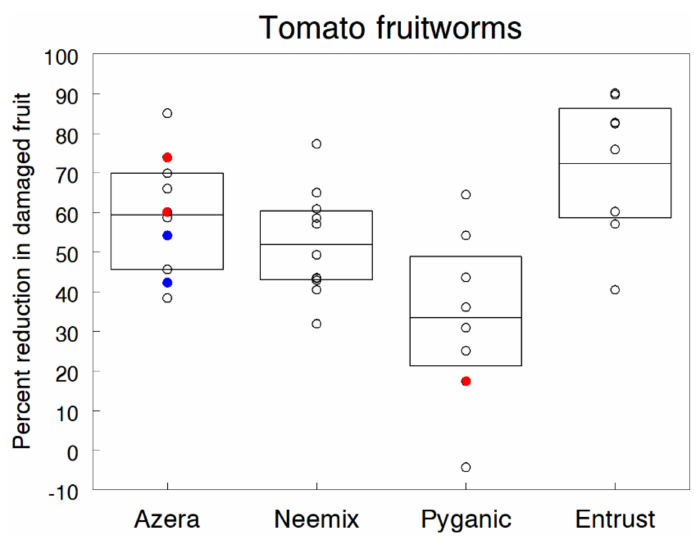
Figure 12. Percent control of tomato fruitworms with applications of Azera, Neemix, PyGanic and Entrust relative to the untreated control. Mean data are compiled from nine tomato trials, each receiving five weekly applications of each insecticide. Box-whisker plots show the 25% and 75% percentile range of percent control data and the horizontal line in each box is the overall mean control e ffi cacy. Application rates of Azera, Neemix, PyGanic and Entrust were 2.34 L / h, 1169 mL / h, 2.34 L / h and 71.2 g a.i. / h respectively, except for individual trial data in blue and red indicating lower and higher rates, respectively. There were no significant di ff erences in control among